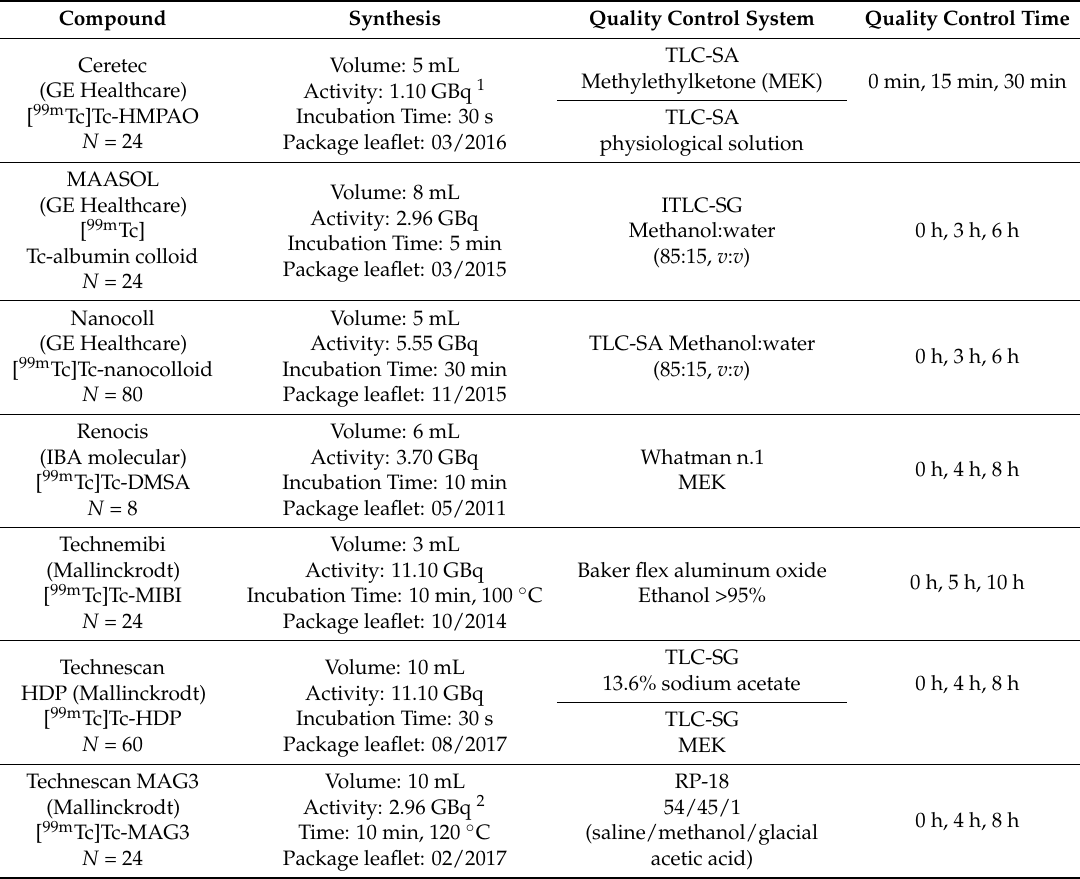
Table 2. Summary of the experimental conditions. We chose to use, for each preparation, the maximum activity and the maximum volume allowed by the